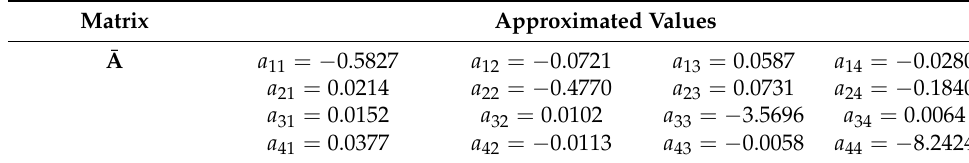
Table 2. Approximation values of unforced matrix.